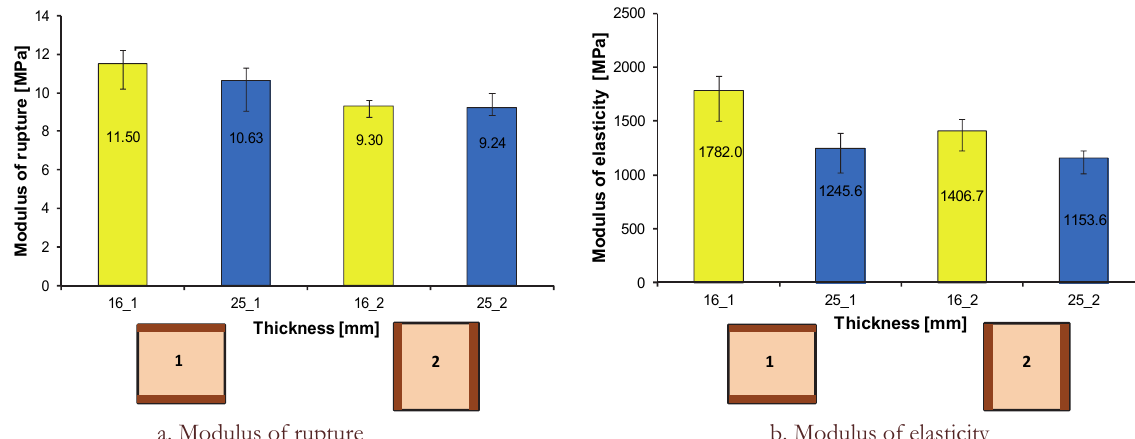
Figure 3: Mechanical properties of